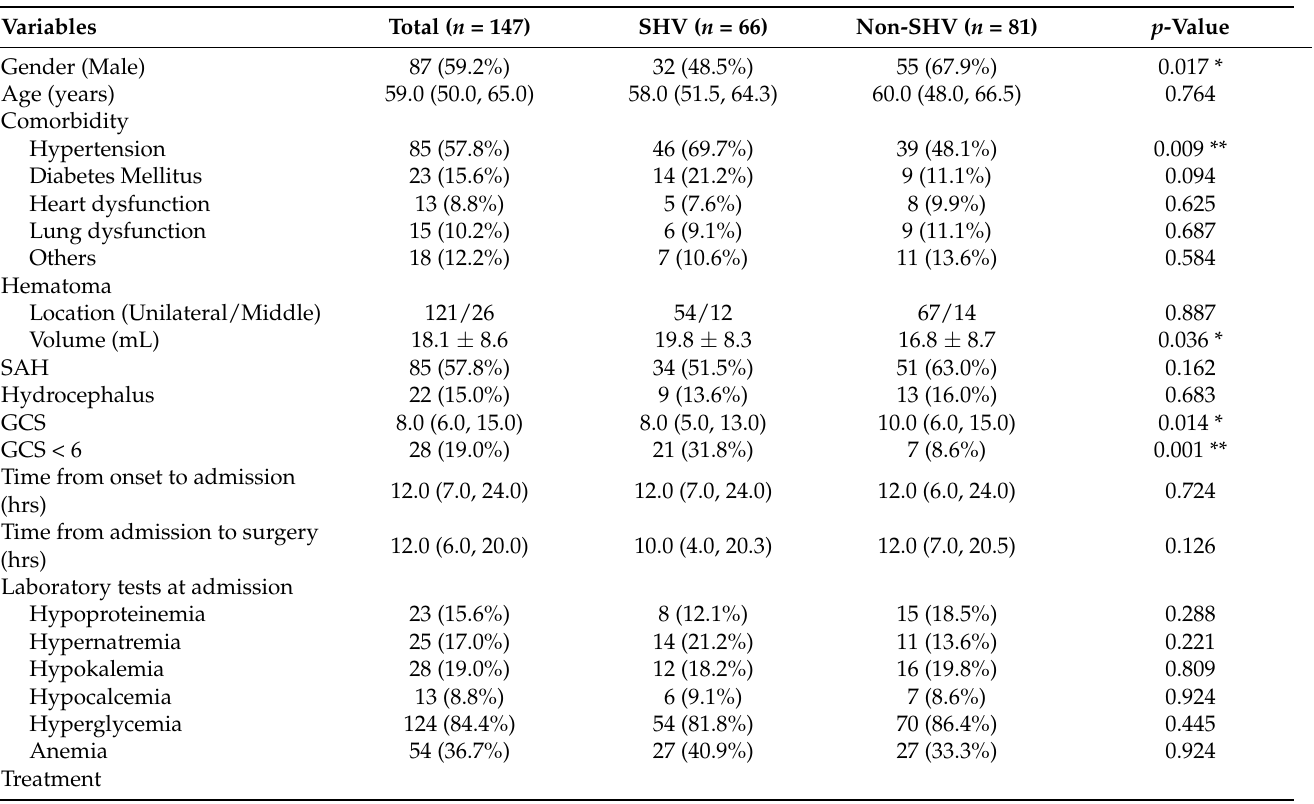
Table 1. Clinical characteristics of patients with and without spontaneous